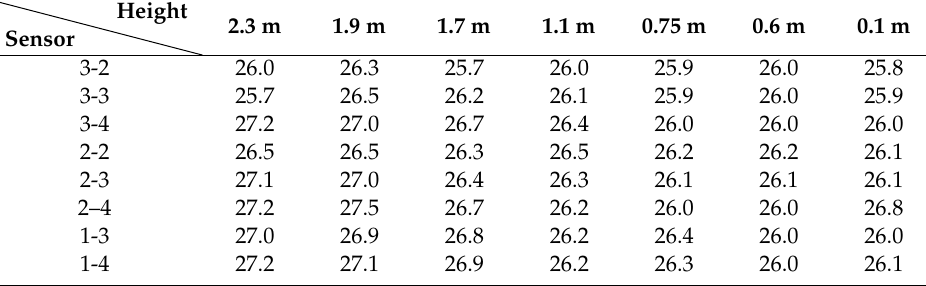
Table 6. Indoor temperature at di ff erent levels under condition